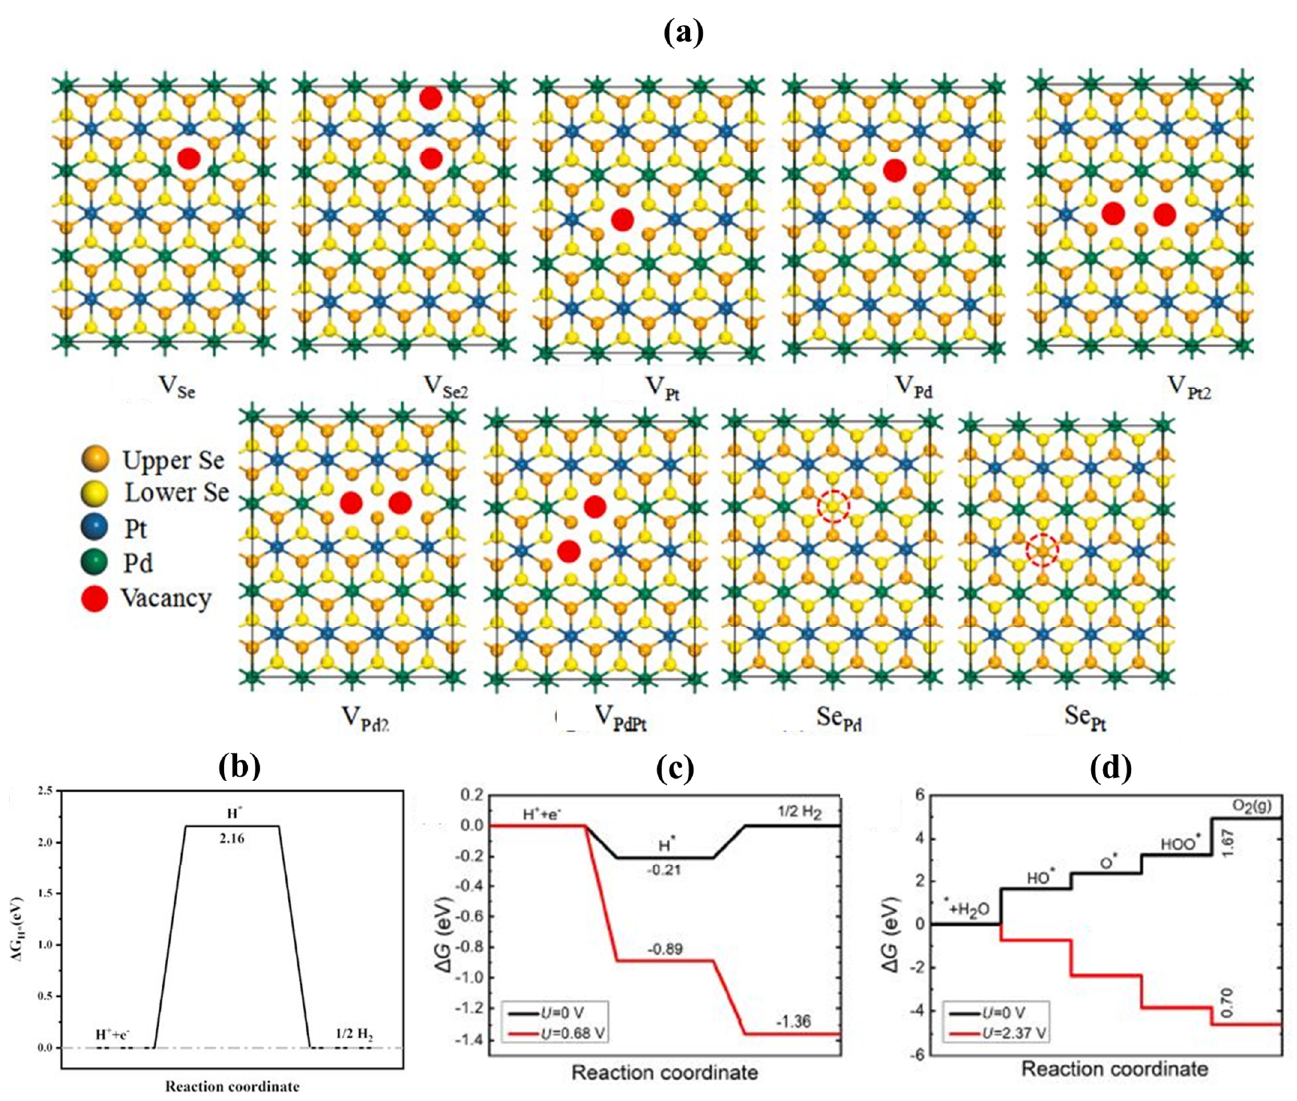
Figure 7. ( a ) The schematic diagrams of nine-point defects (V Se , V Se2 , V Pt , V Pd , V Pt2 , V Pd2 , V PdPt , Se Pt , Se Pd ) in PdPtSe 4 monolayer. Red dots represent the defect sites. Reprinted with permission from ref. [149]. Copyright 2021 Elsevier. ( b ) Free energy profile for the 2e pathways of hydrogen reduction reactions in the Janus InGaSSe bilayer under pH = 0 and U = 0 V. The 2e and 4e for ( c ) HER and ( d ) OER pathways in the Janus InGaSSe bilayer with Ge defect under different conditions. Reprinted with permission from ref. [150]. Copyright 2018 Elsevier.